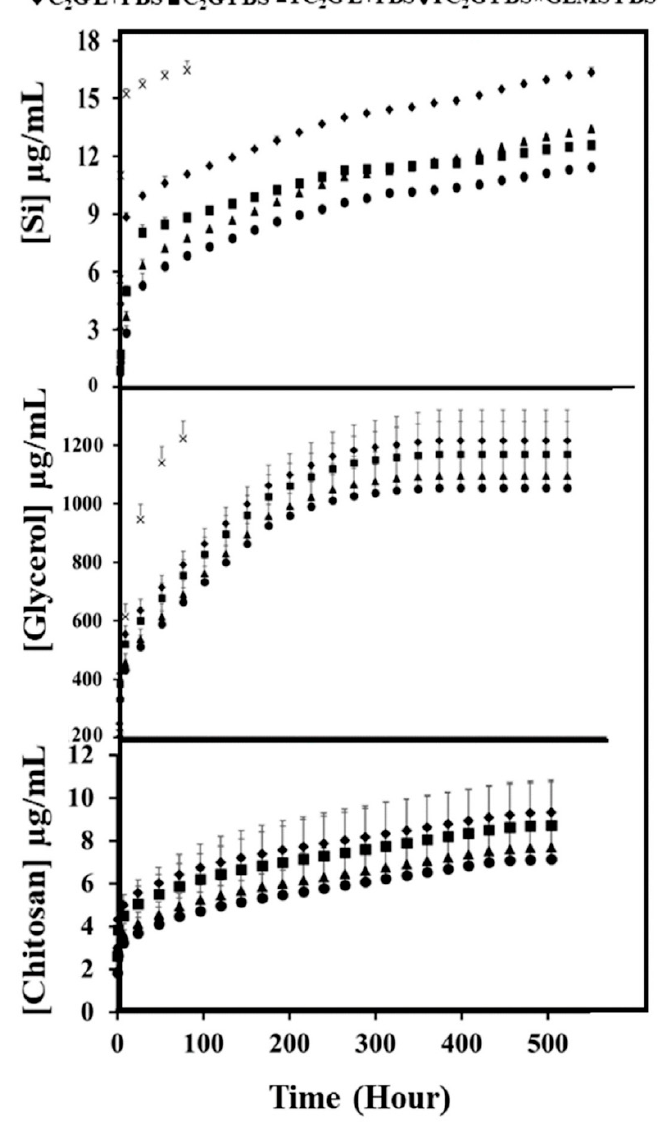
Figure 3. Accumulation of silica, glycerol and chitosan degradation products released in degradation solution of TC 2 G and C 2 G up 504 h. E+PBS: degradation solution containing lysozyme, PBS: only PBS.